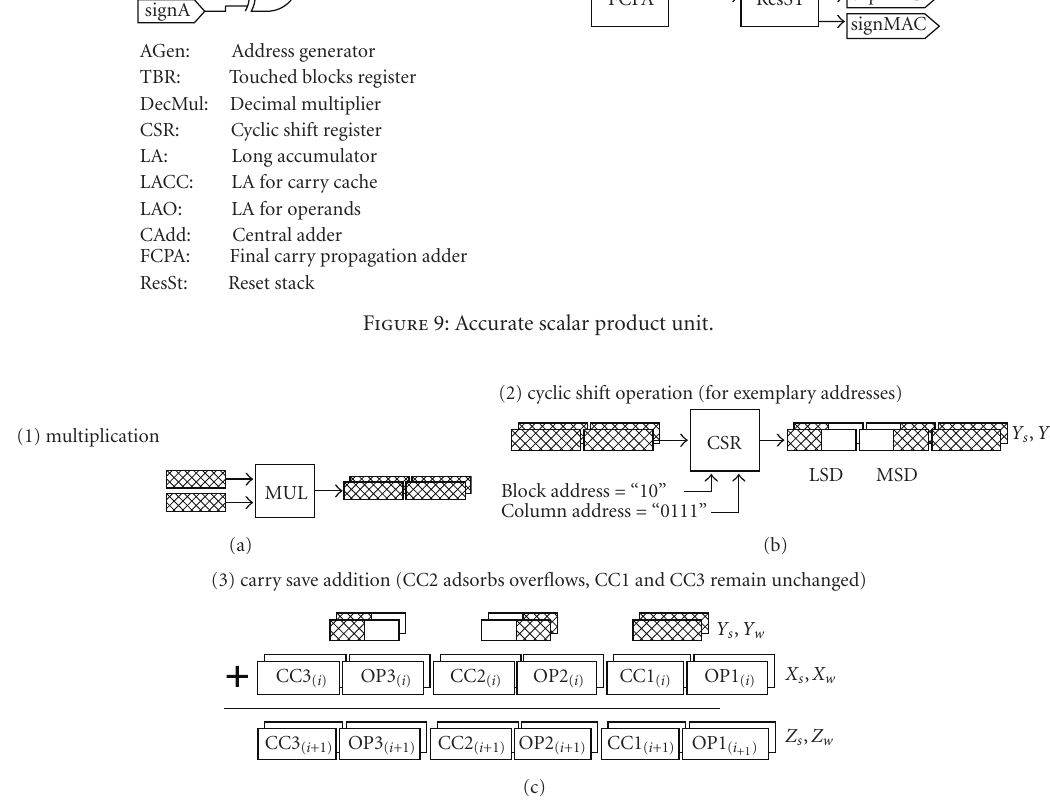
Figure 10: Block alignment of LA and